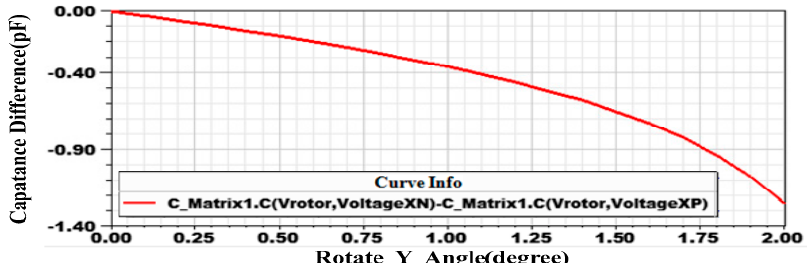
Figure 8. Capacitance difference for different deflection angles.